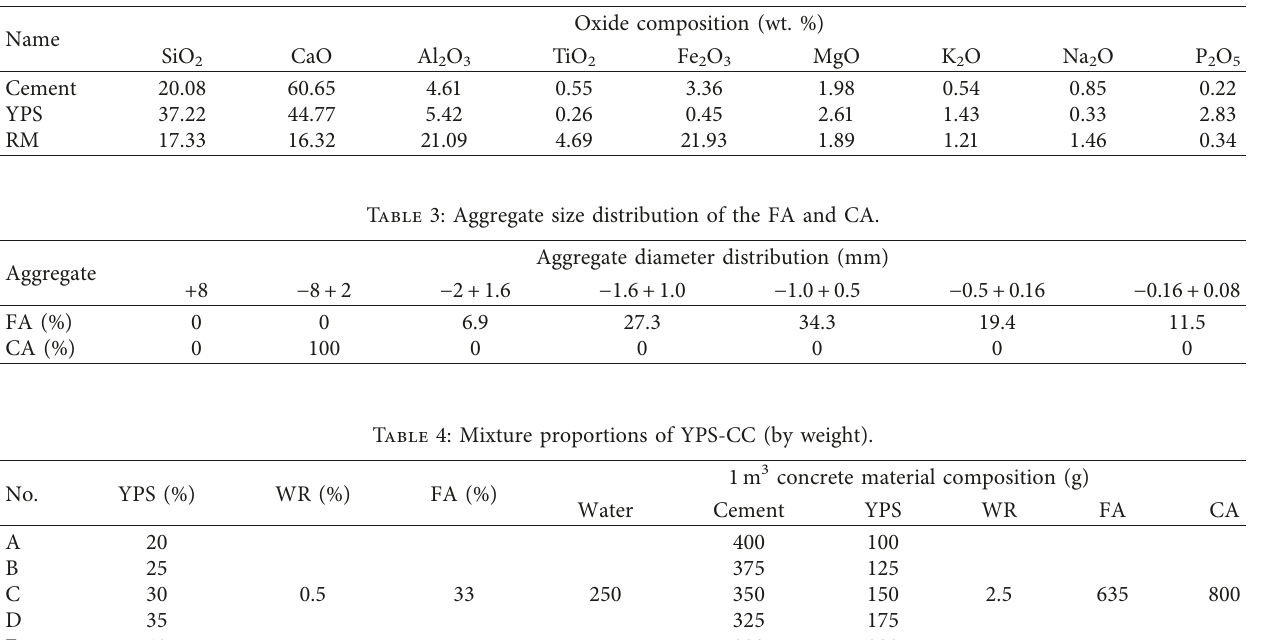
Table 2: Chemical composition of cement, YPS, and RM.